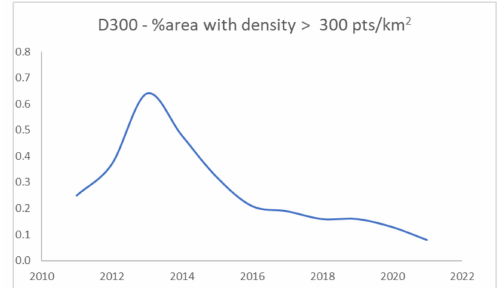
Figure 18. Trend of the percent of areas with density points greater than 300 pts/km 2 for shoplifting in the Liverpool Street cluster.